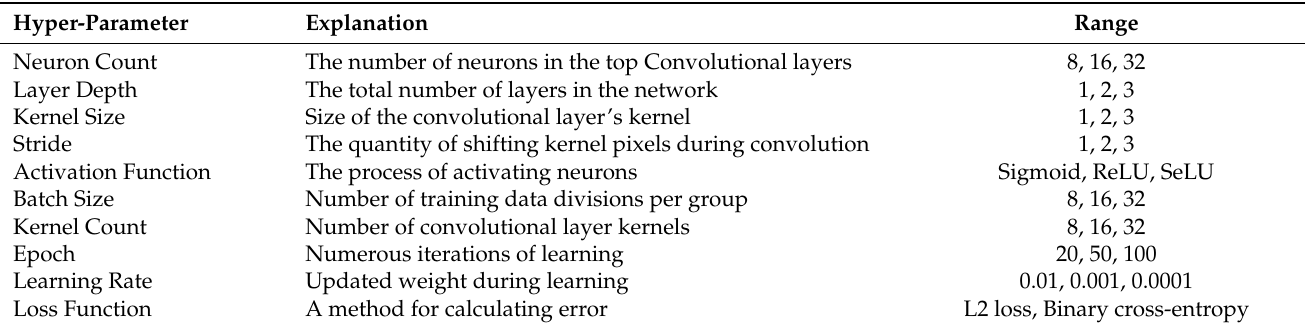
Table 1. The CNN model hyper-parameter settings and their